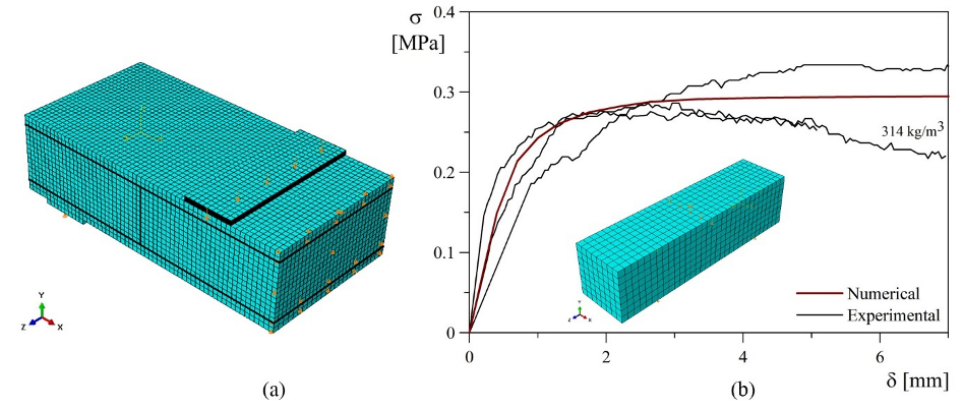
Figure 4. FE model: geometry and constraints (a) and validation of core material model considering three-point bending (b).